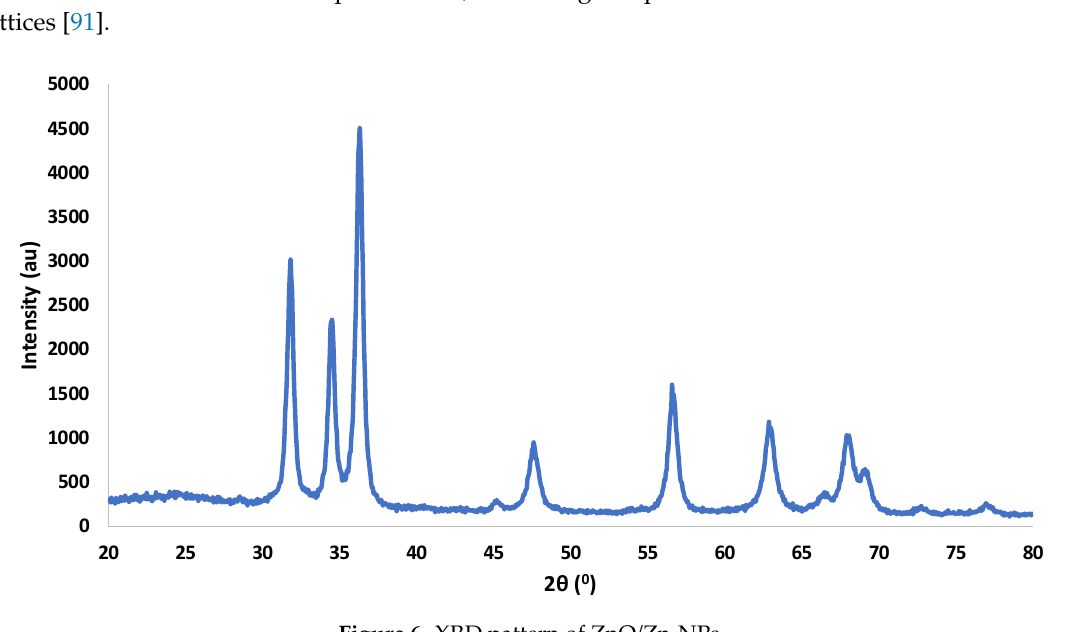
Figure 6. XRD pattern of ZnO/Zn-NPs.